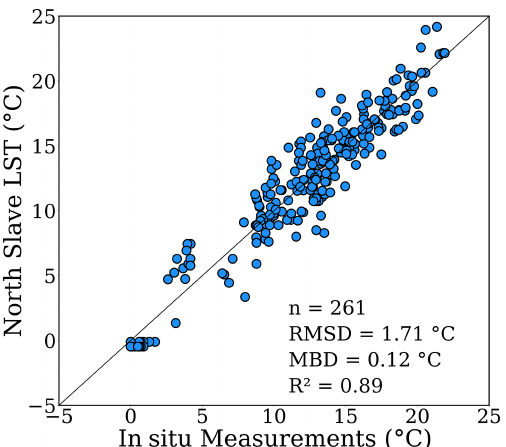
Figure 5. Comparison of North Slave LST with DataStream and ECCC in situ measurements of water surface temperature during open-water